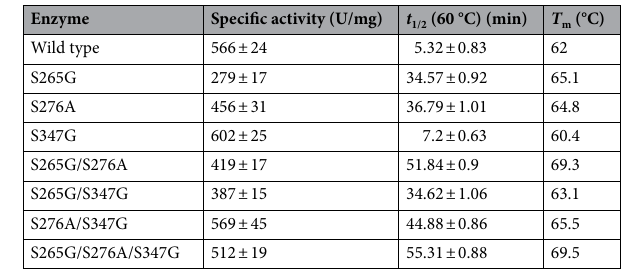
Table 2. Activity and thermostability of csnTS and its mutants: specific activity, t 1/2 (60 °C) and optimum temperature.